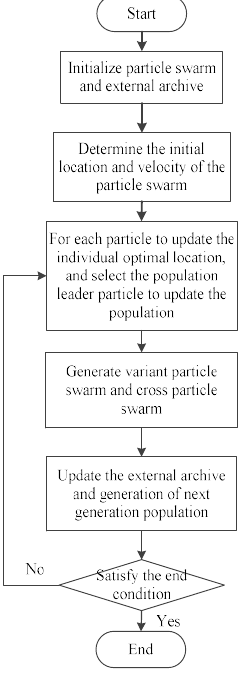
Figure 4. MOPSO flowchart.